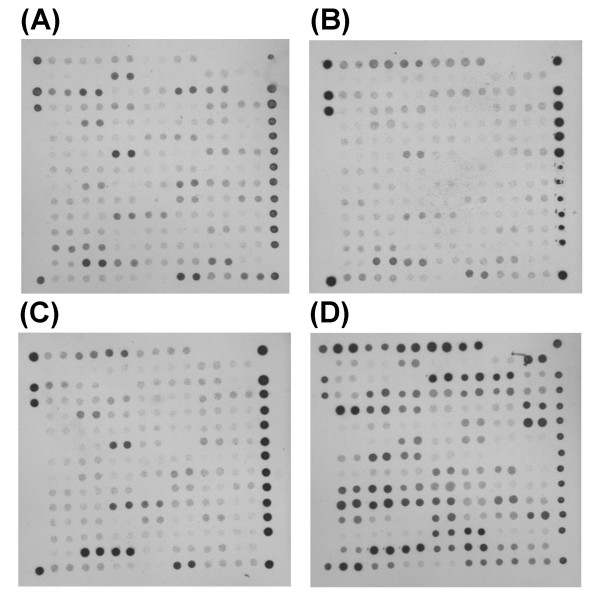
A direct comparison of the hybridization pattern of samples generated from total RNA of DLD-1 by the different labelling procedures. (A) Labelling of 20 μg total RNA in the course of reverse transcription (biotinylated Oligo-dT), hybridization for 18 h at 45°C, 1 ng polyA-spike in controls were added. (B) 5 μg total RNA were reverse transcribed and the resulting cDNA was labelled by Klenow fragment exo-. (C) Labelling of ds-cDNA generated from 500 ng total RNA in the course of overall linear amplification with the SPA-primer. (D) Labelling of ds-cDNA generated from 100 ng total RNA and 10 pg polyA-spike in controls in the course of linear amplification with the complete set of specific primers according to the protocol described in the Methods part.